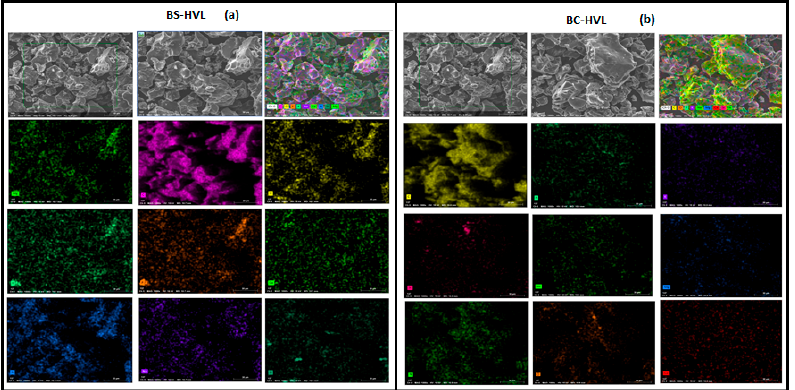
Figure 6. SEM micrographs after adsorption with micrographs of element present in BS-HVL ( a ) and BC-HVL ( b ).